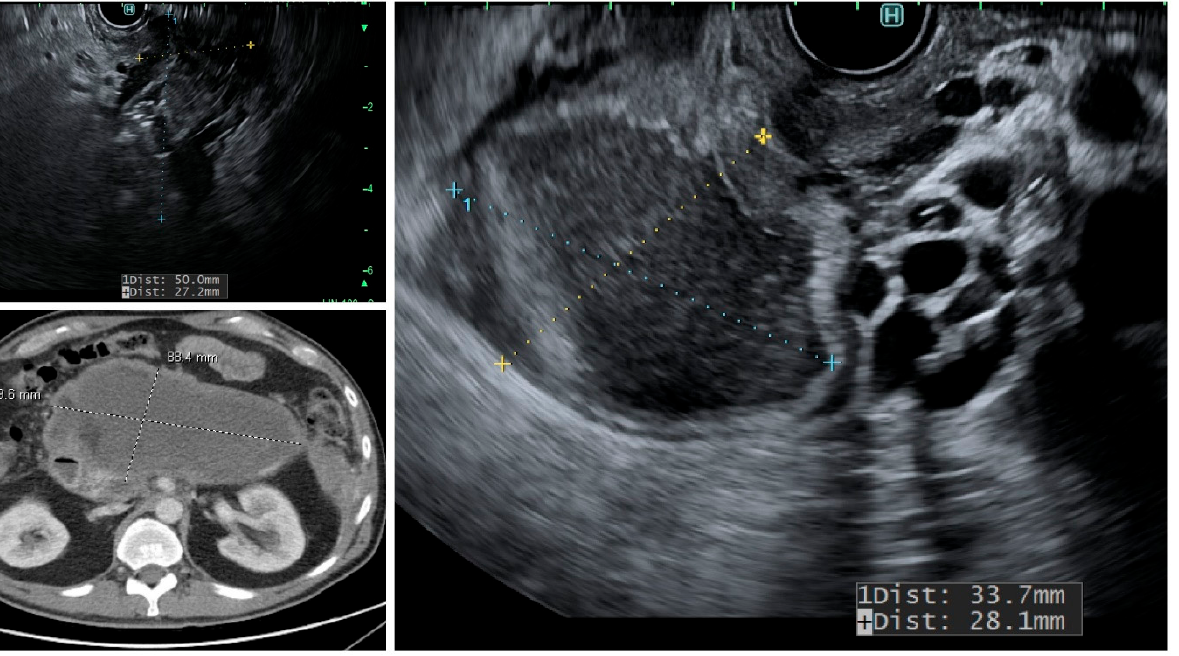
Figure 1. Endoscopic ultrasound and CT scan images showing pancreatic pseudocyst near the uncinate process.